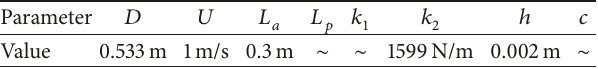
Table 1: Parameters in